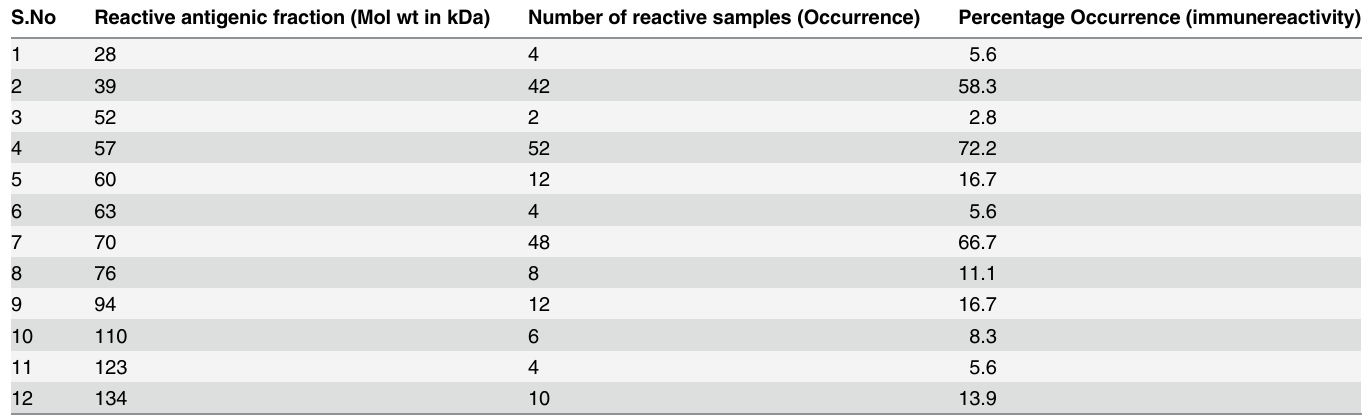
Table 4. Number of serum samples reactive and percentage occurrence by Western blot assay (N = 72). S.No Reactive antigenic fraction (Mol wt in